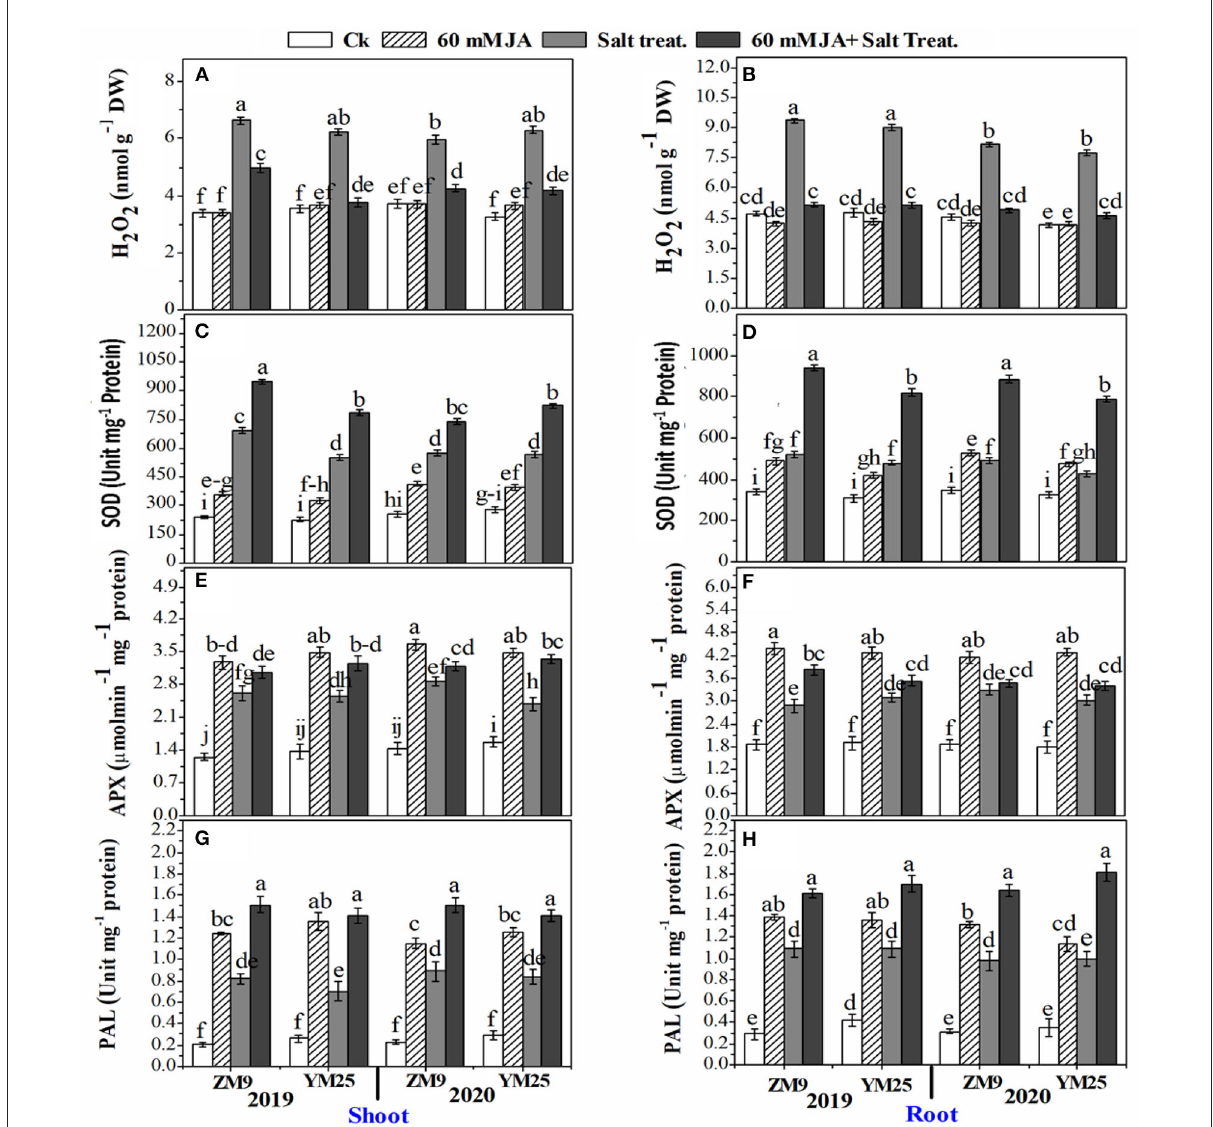
FIGURE2 Effects of JA priming on the production of reactive oxygen species (H 2 O 2 ) in the shoot (A) and root (B) ; SOD in the shoot (C) and root (D) ; APX in the shoot (E) and root (F) ; PAL in the shoot (G) and root (H) of two wheat cultivars Mai9 (ZM9, salt-sensitive) and Yang Mai25 (YM25, salt-tolerant) under control and salinity stress conditions during two consecutive growing seasons 2019 and 2020. Means sharing the same letters, for a parameter during a year, do not differ significantly at P ≤ 0.05 among the studied factors. SOD, superoxide dismutase;